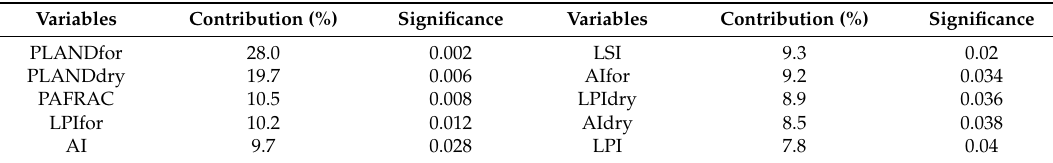
Table 4. Selected landscape indexes for further redundancy analysis (RDA) by the Monte Carlo permutation test ( n =